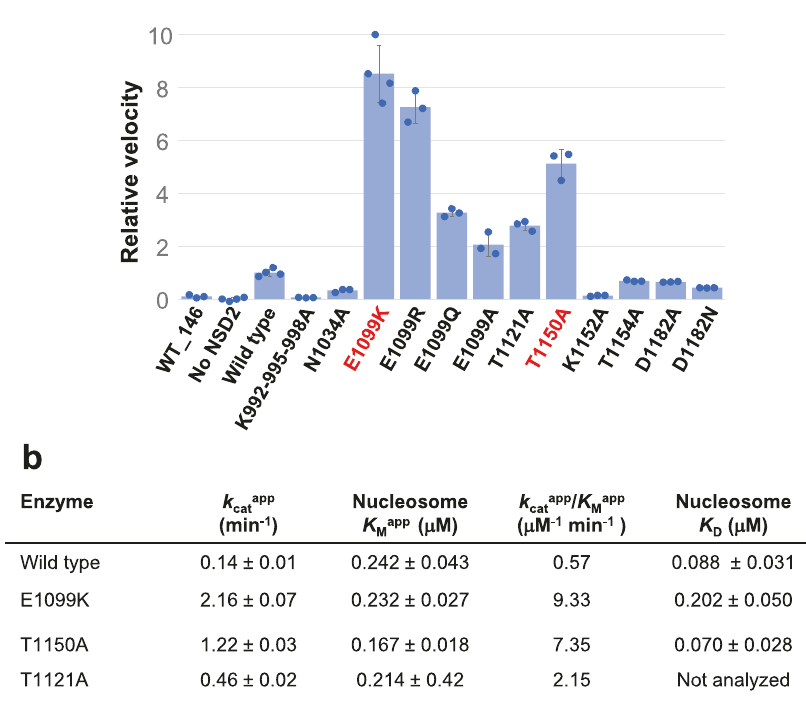
Fig. 4 Mutational analyses. a Summary of the enzymatic analysis, showing the relative reaction velocity. Data were presented as mean ± standard deviation of independently generated datasets ( n ≧ 3). Source data are provided as a Source data fi le. b Kinetic values and dissociation constants between the NSD2 proteins and the nucleosome with the 185-bp DNA